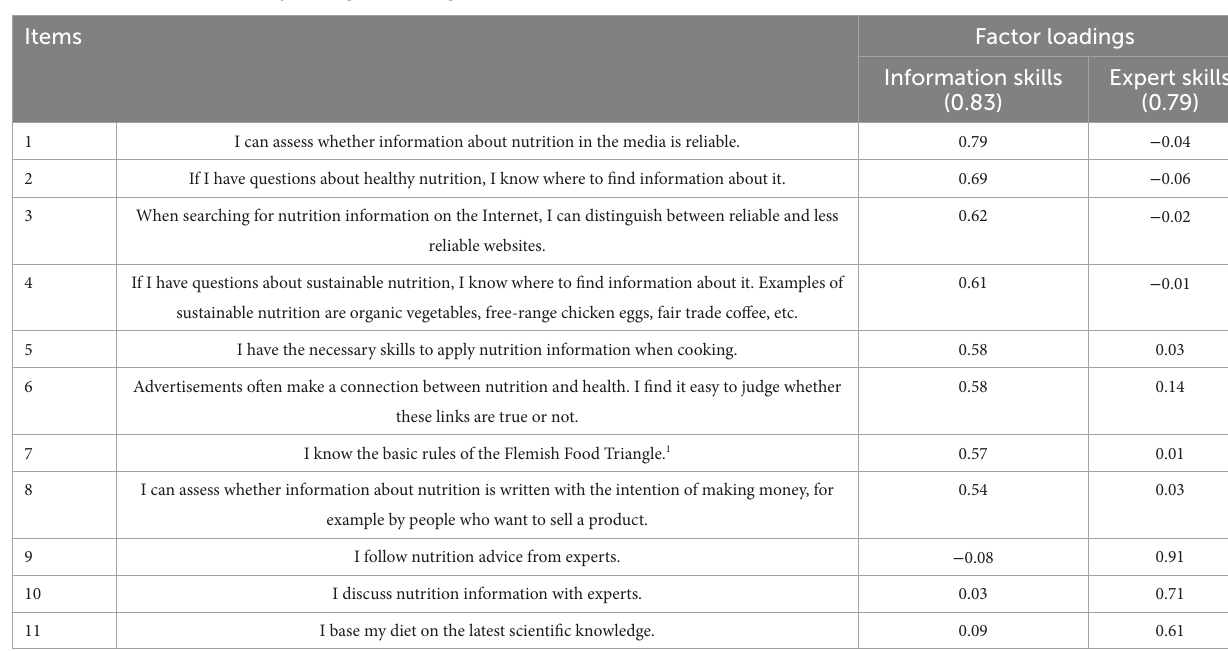
TABLE 2 Pattern matrix of the exploratory factor analysis.